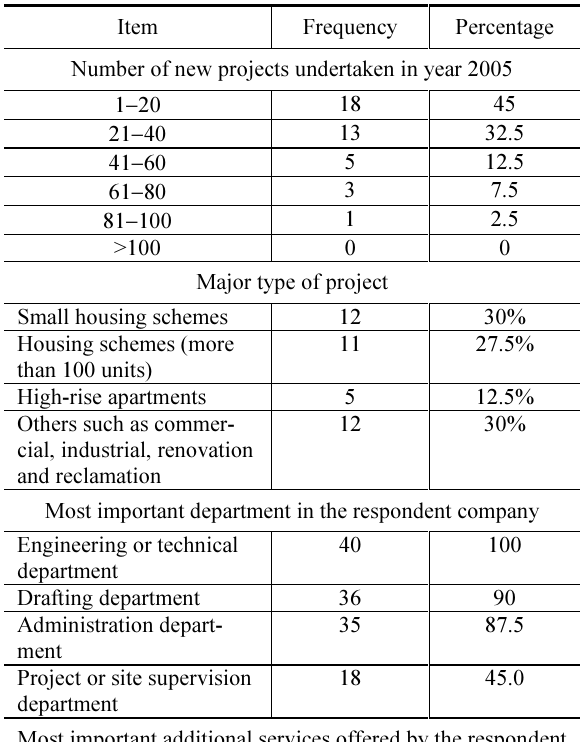
Table 2. Respondent’s company project profiling and